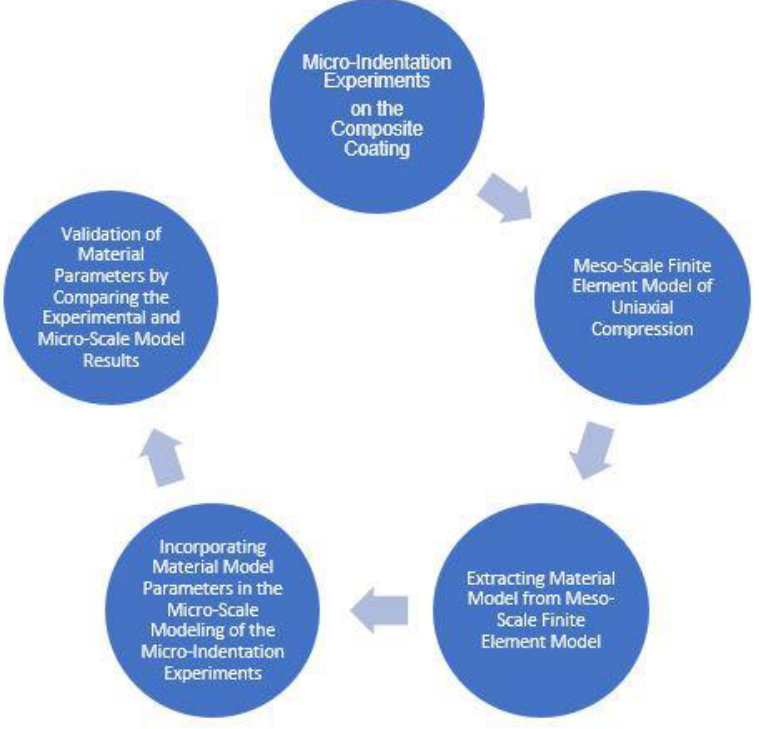
Figure 1. Flowchart of the proposed methodology for identifying the material model parameters of composite coatings.